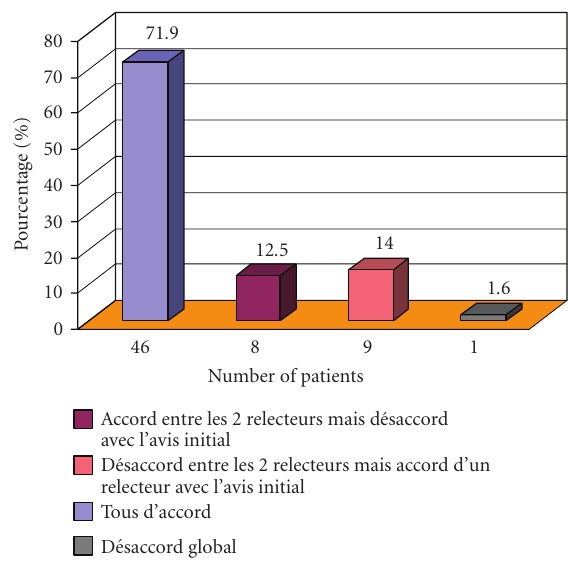
Figure 1: Cytologic